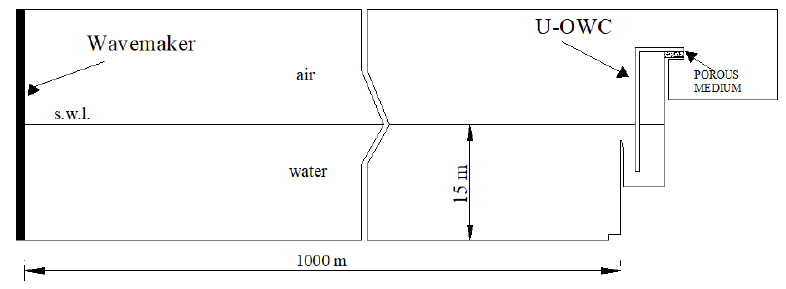
Figure 2. Sketch of the numerical wave flume (measures are in meters).